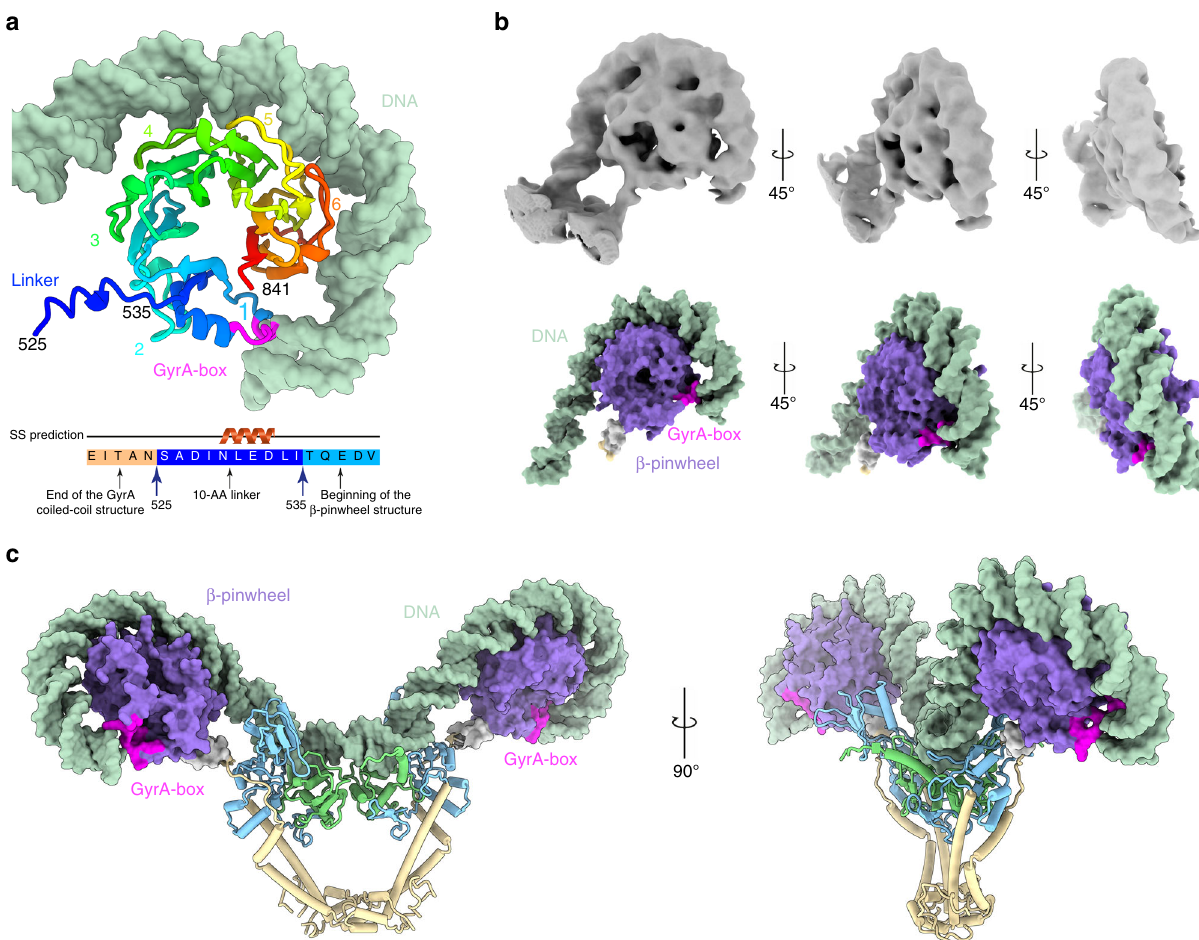
Fig. 3 DNA Wrapping around the GyrA CTD β -pinwheel and GyrA-box structure. a Cartoon representation of the molecular structure of the GyrA β - pinwheel, rainbow colored from the N-terminal end in blue, to the C-terminal end in red. The GyrA-box (QRRGGKG) is colored in magenta and DNA in pale green. The β -pinwheel blades are numbered from 1 to 6. The fi rst contact between DNA and the β -pinwheel occurs at blade 3, wraps around the disk by contacting blade 4, 5, 6 and exits the β -pinwheel through contact with blade 1. b Different views of the 6.3 Å cryo-EM map (in grey) zoomed on the β - pinwheel wrapped with DNA and the corresponding molecular models in surface representation (same color code as in Fig. 2). The slight superhelical structure of the pinwheel is clearly visible on the side view. c Overall view of the 130 bp DNA duplex wrapping around the two β -pinwheels of DNA gyrase. For clarity, only the GyrA subunits are displayed. The GyrA-box motifs of each β -pinwheel are located at the exit of the DNA path around the β -pinwheel and act as clamps stabilizing the DNA